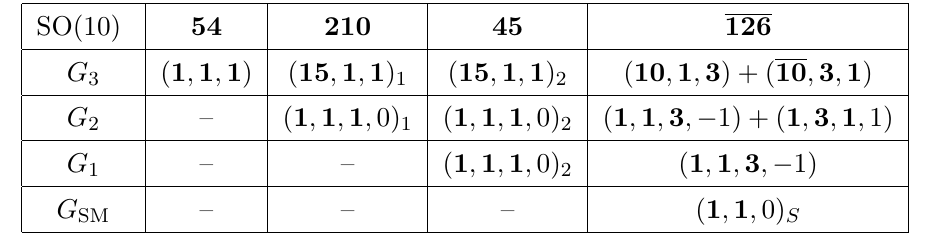
Table 2 . Decomposition of the Higgses which induce spontaneous symmetry breaking at each step of the breaking chain. Each Higgs (from left to right) is eventually decomposed to a singlet whose non-vanishing VEV preserves the symmetry G (for I = 3 , 2 , 1 , SM ) in the same row but breaks I larger symmetries. The subscript distinguishes different fields of the same